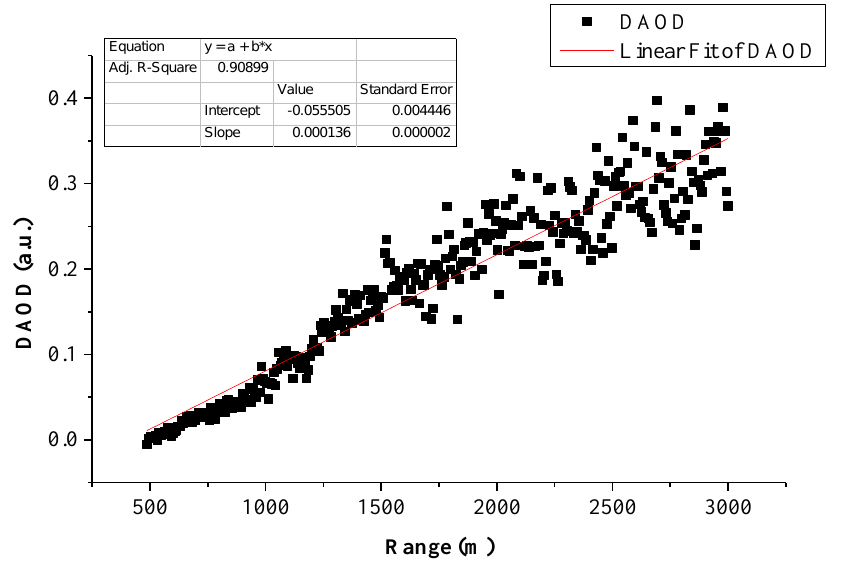
Figure 12. DAOD of the spliced signal.